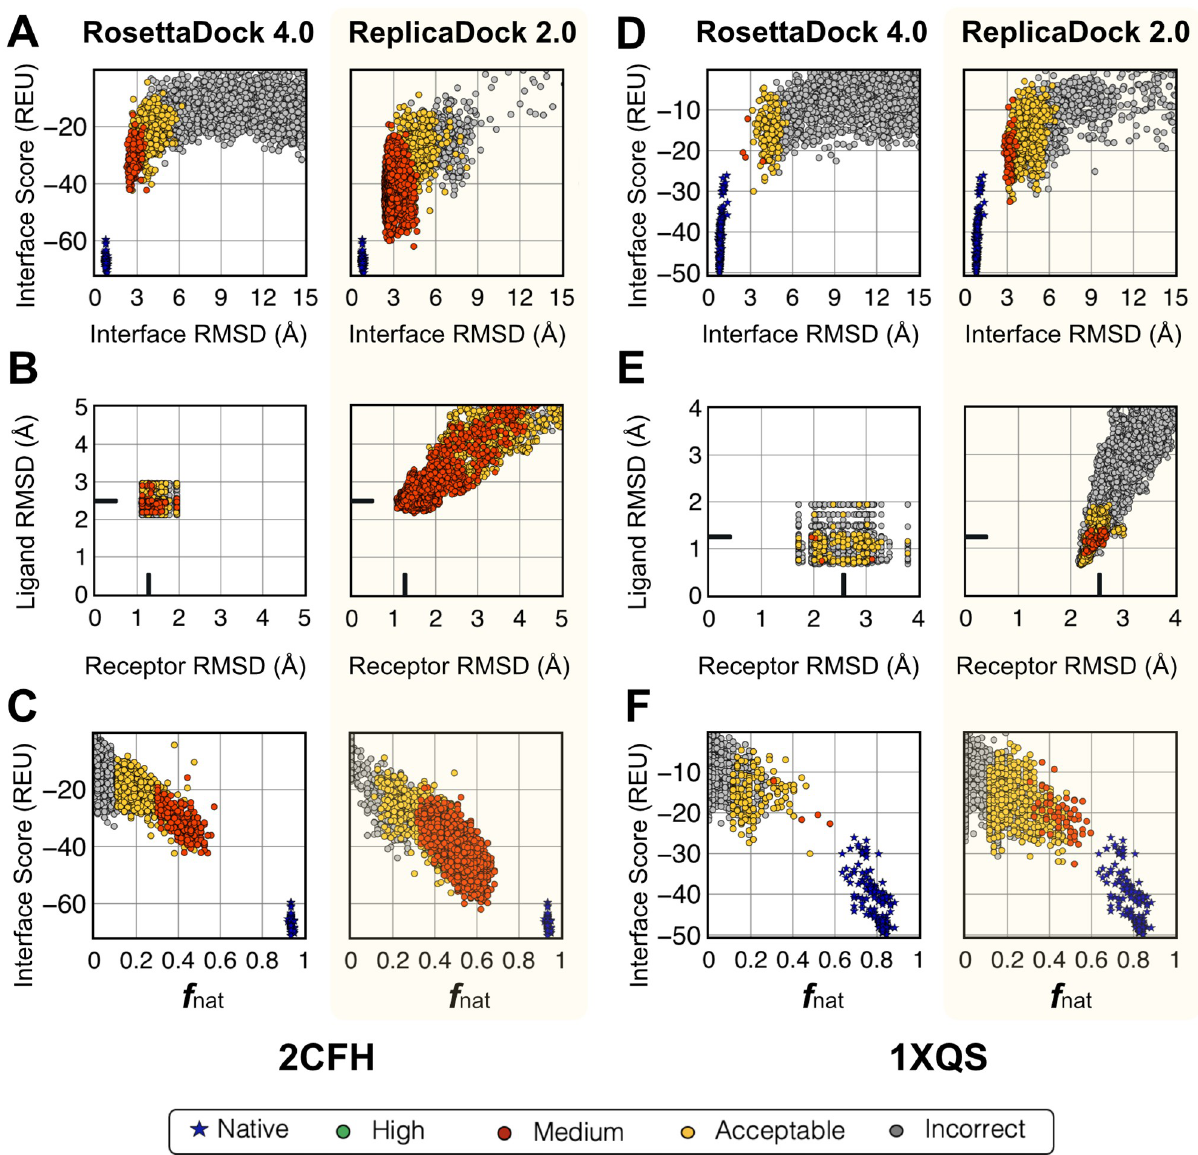
Fig 3. Improvement in docking performance after full protocol for two representative targets. (A,D) Interface score (REU) vs I-rmsd ( Å ), (B,E) Ligand-RMSD( Å ) versus Receptor-RMSD( Å ), and (C,F) Interface score (REU) vs fraction of native-like contacts post all-atom refinement for RosettaDock 4.0 [11] and ReplicaDock 2.0(this work) for two targets 2CFH and 1XQS. Relative to RosettaDock 4.0, ReplicaDock 2.0 samples decoys that score better, are closer to the native, have higher native-like contacts( f nat ) and better CAPRI quality. However, backbone RMSDs (B,E) have not moved closer to the native but rather diverged away from